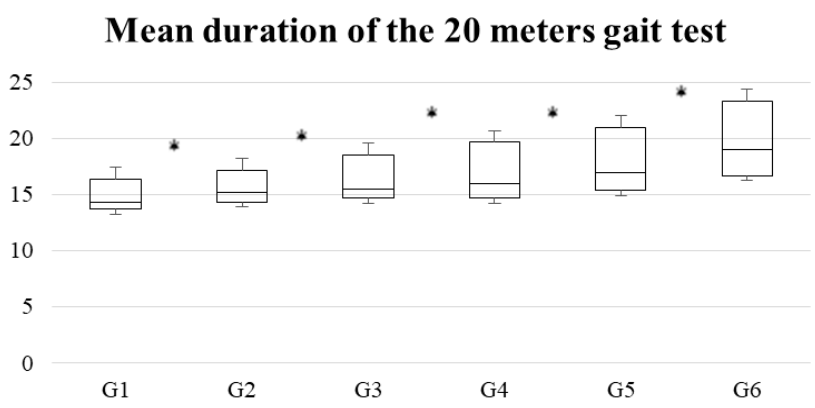
Figure 3. Box chart for the duration of the gait test by age group. * Indicates statistically significant di ff erences ( p < 0.05) between the groups in which it is found.